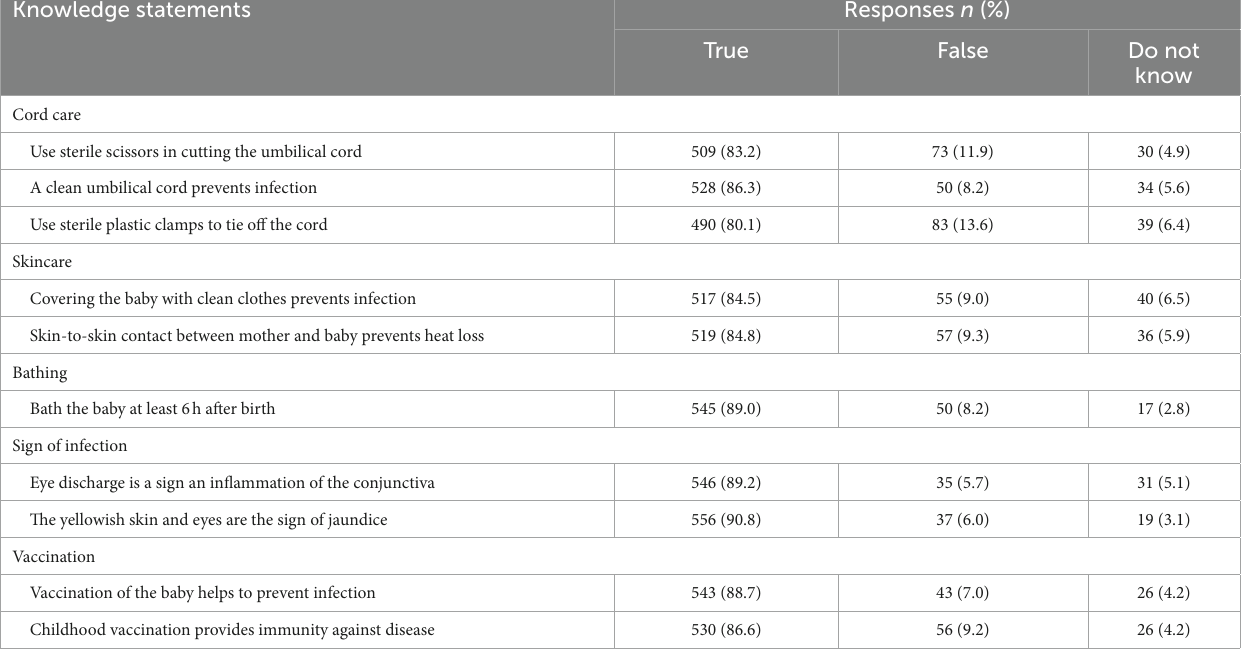
TABLE 2 Knowledge of infection prevention in neonates ( n = 612).